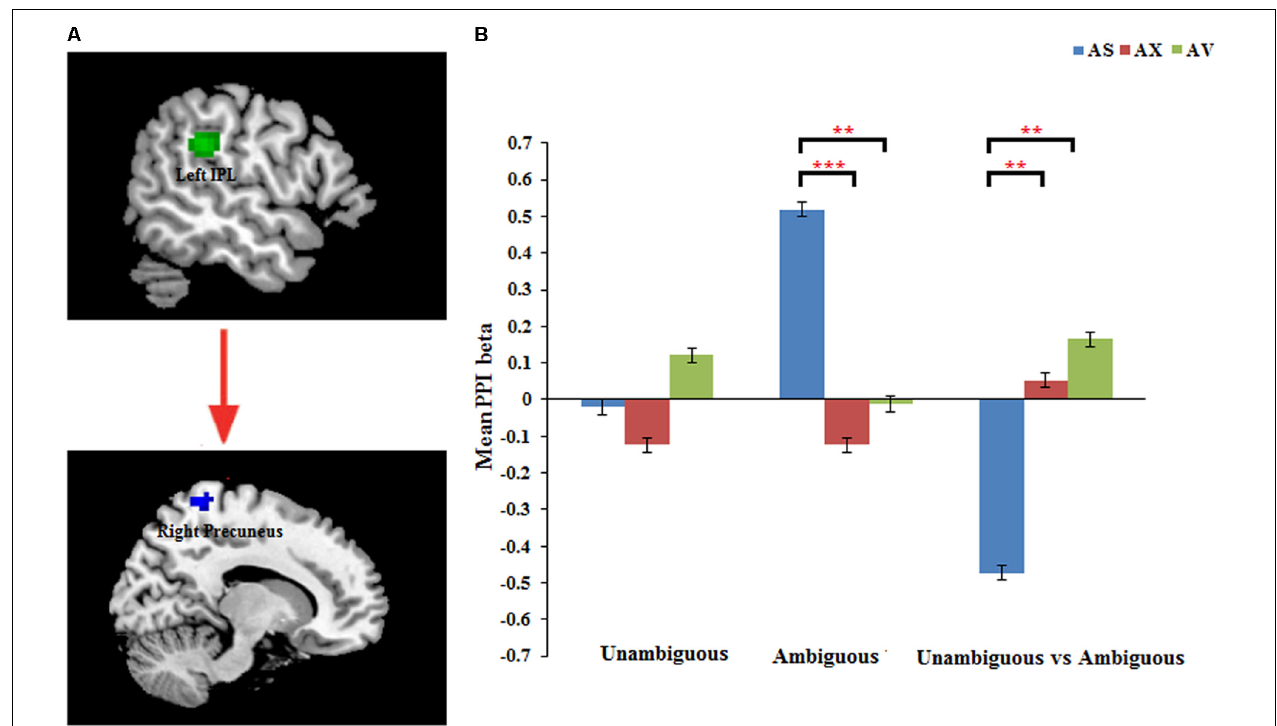
FIGURE 2 | (A) The interaction between attachment group and Preference condition for left IPL in right precuneus. (B) Bar chart displays the mean PPI beta in secure attachment group (blue), anxious attachment group (red) and avoidant attachment group (green) for unambiguous, ambiguous and unambiguous vs. ambiguous conditions. Detailed results can be found in Table 6 . The asterisks ( ∗ ) indicate significant differences ( ∗∗ p ≤ 0.01, ∗∗∗ p ≤